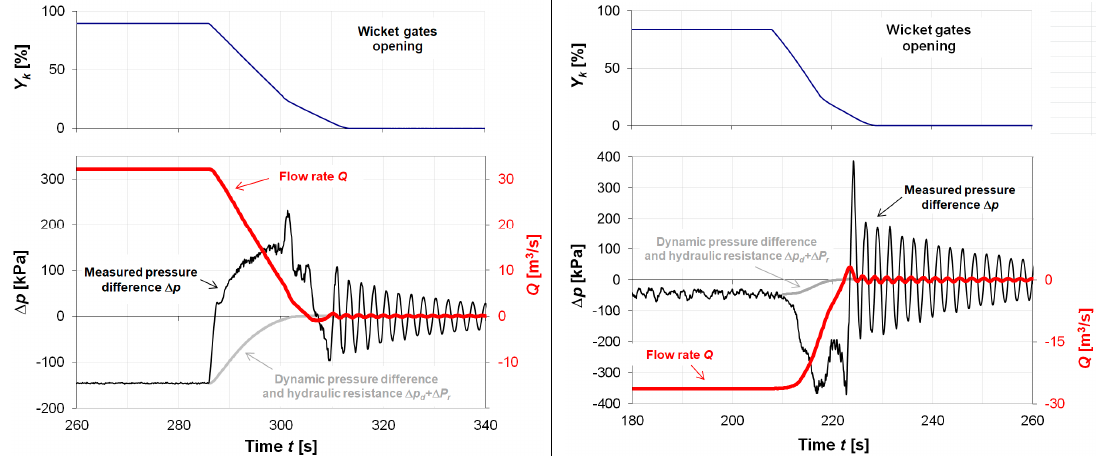
Figure 9. Examples of measured values of wicket gates opening and pressure difference and discharge through the machine calculated using the pressure time method. Left view: turbine operation mode, right view: pump operation mode.